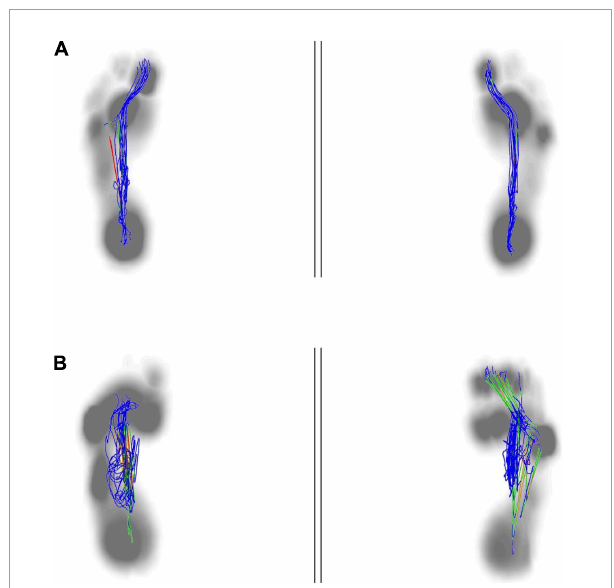
FIGURE6 Anterior to posterior position of center of plantar. The anterior to posterior pressure line start from the heel to the big toe. The normal plantar pressure trajectory from anterior to posterior was almost overlapped (A) . The plantar pressure trajectory from anterior to posterior in stroke patient was not exactly overlapping, mainly concentrated in the midfoot, and was shorter than the healthy people (B) .